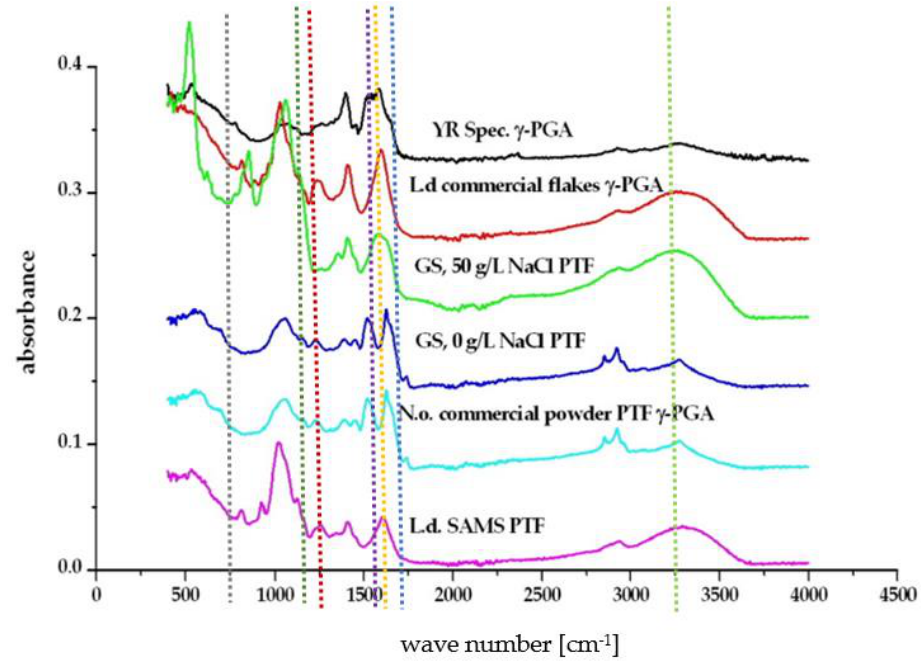
Figure 2. Fourier Transform Infra-Red spectra of γ -PGA obtained from different standard and complex waste substrates. The blue vertical line represents the C=O stretch, the orange line represents the Amide I N-H bend, the purple line represents the Amide II stretch, the red line represents the C=O symmetric stretch of γ -PGA in its sodium (1402 cm − 1 ) or calcium (1412 cm − 1 ) isoform, the dark green line represents the C-N stretch, the grey line represents the N-H bending, the light green line represents the O-H stretch.